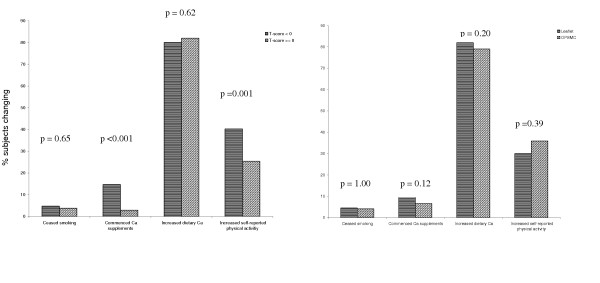
Effect of intervention on change in osteoporosis preventive behaviors (a) by T-score(b) by educational intervention. P-values are for comparison of proportion of subjects changing each behavior between T-score groups and between educational intervention groups at two years. Significant differences in behavior change between groups were only observed for calcium supplement use and self-reported physical activity between T-score groups. The type of educational intervention did not affect the proportion of subjects changing osteoporosis preventive behaviors.